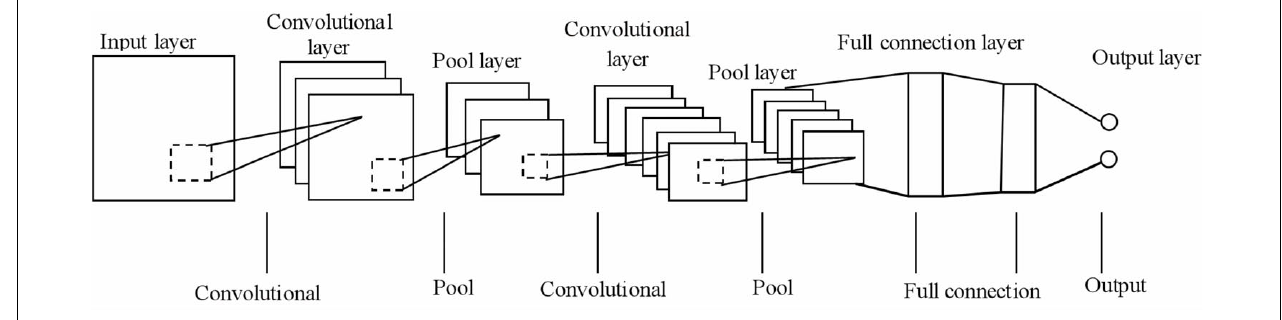
FIGURE 1 | Architecture of constructive neural network